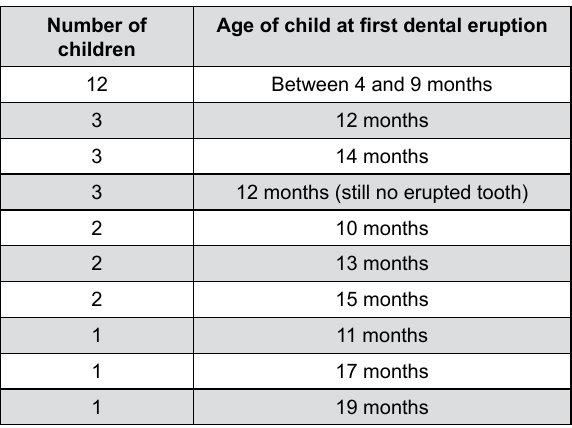
Figure 3- Results for age at first dental eruption and number of